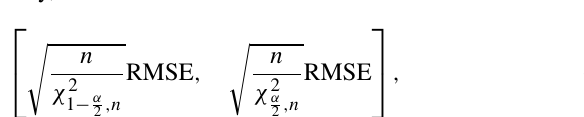
Figure 13. Procedure for finding the TIE-GCM forecast using an MME as its initial conditions. The “run TIE-GCM MME forecast” process refers to the procedure described in Fig. 12.